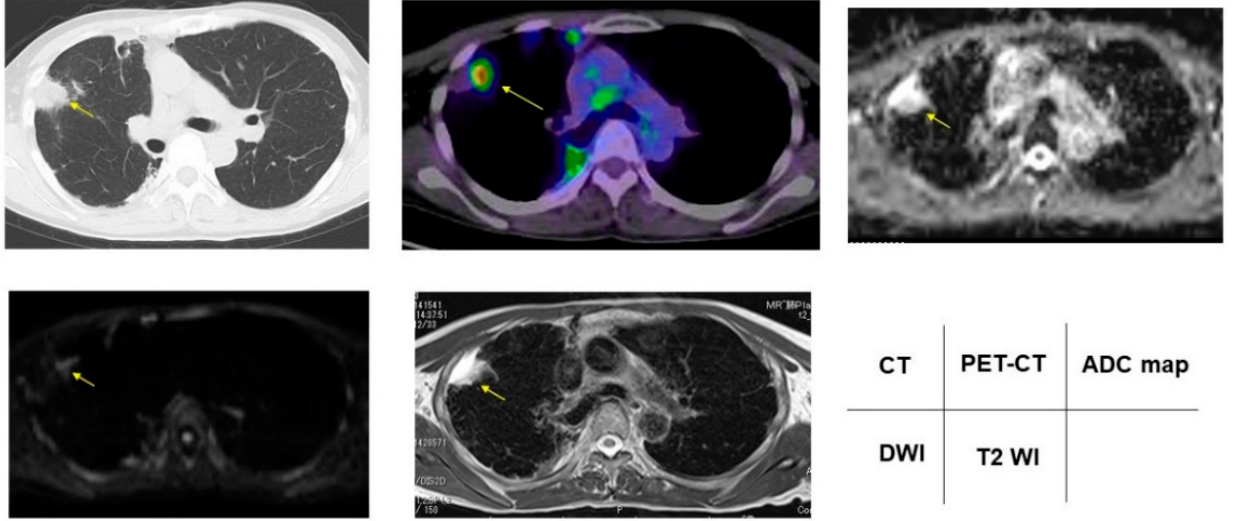
Figure 4. Nontuberculous mycobacteria showed 5.00 for SUVmax, DDS 3, 2.50 × 10 − 3 mm 2 /s for ADC, and 4.00 for T2 CR. Yellow arrows shows PNMs.